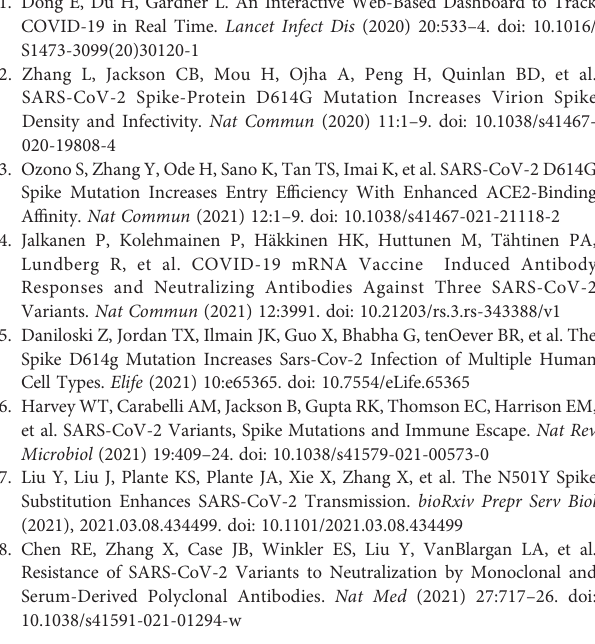
Supplementary Figure S4 | Evaluation of cellular immune response through ELISPOT upon stimulation with Mega Pools of Spike peptides derived from SARS- CoV-2 WT and variants of concern in volunteers immunized with CoronaVac. Numbers of IL-4-secretingcells, determined through ELISPOT asspot formingcells (SFCs)weredetermined. PBMCswerestimulated withMP-SWT,MP-SAlpha,MP- S Beta, MP-S Gamma and MP-Delta for 48 h for samples obtained 2 weeks after the second dose of volunteers of the 0-14 schedule (n = 11) and 0-28 schedule (n = 7). A total of 18 volunteers were evaluated. Data shown represents mean 95% CI and the mean is indicated above each bar. Statistical differences were evaluated by a one-way ANOVA followed by Dunnett ’ s test for multiple comparisons against the MP-S